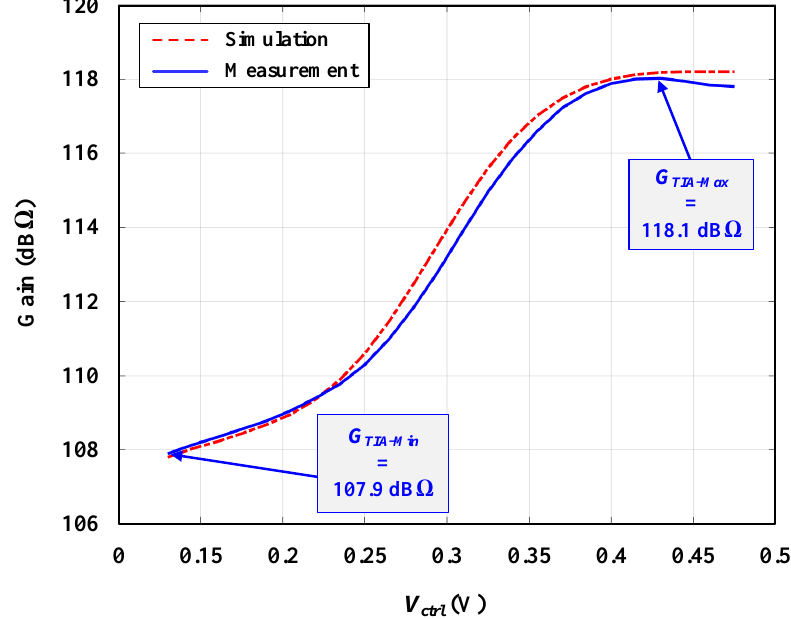
Figure 13. Measured tunable TIA gain from 108 dB Ω up to 118.03 dB Ω compared to simulation.